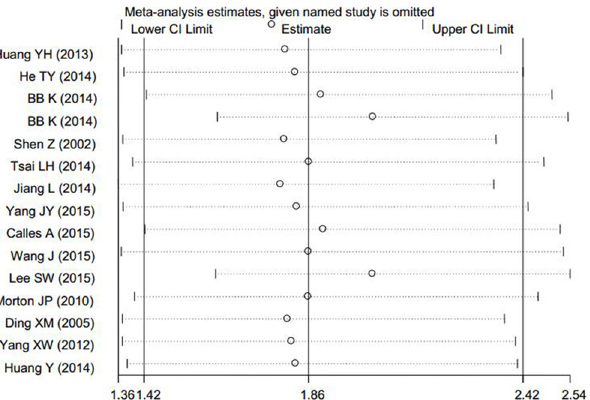
Fig 3. Sensitivity analysis of the OS in the meta-analysis (note: BB K was used as an abbreviation for Bouchekioua-Bouzaghou K because the full name was too long and affected the typesetting of the image).